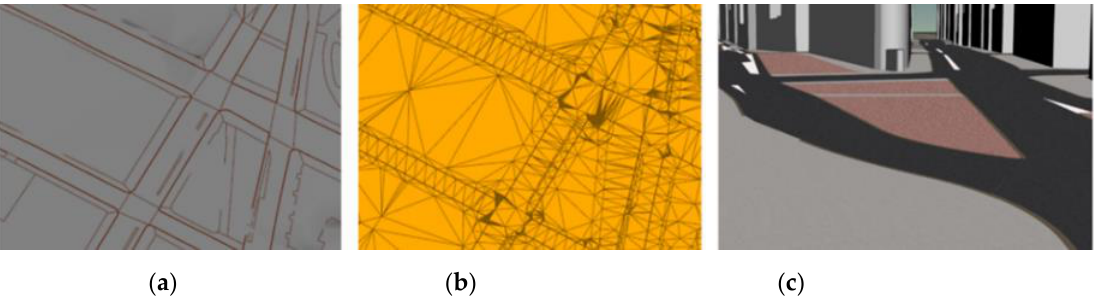
Figure 10. ( a ) Object breaklines on DEM, ( b ) Triangulated surface, ( c ) Result.